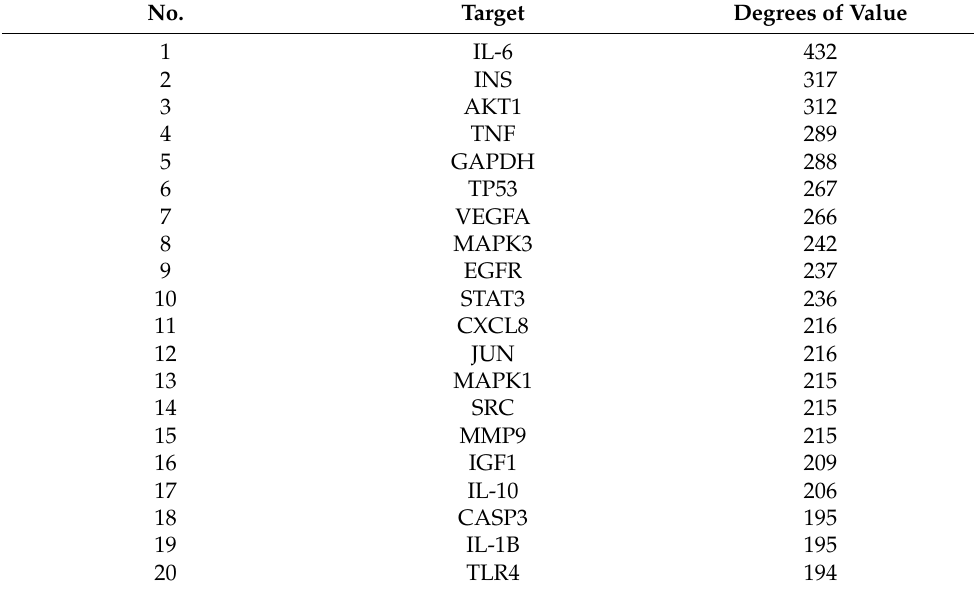
Table 1. Degrees of value of the top 20 targets from PPI.